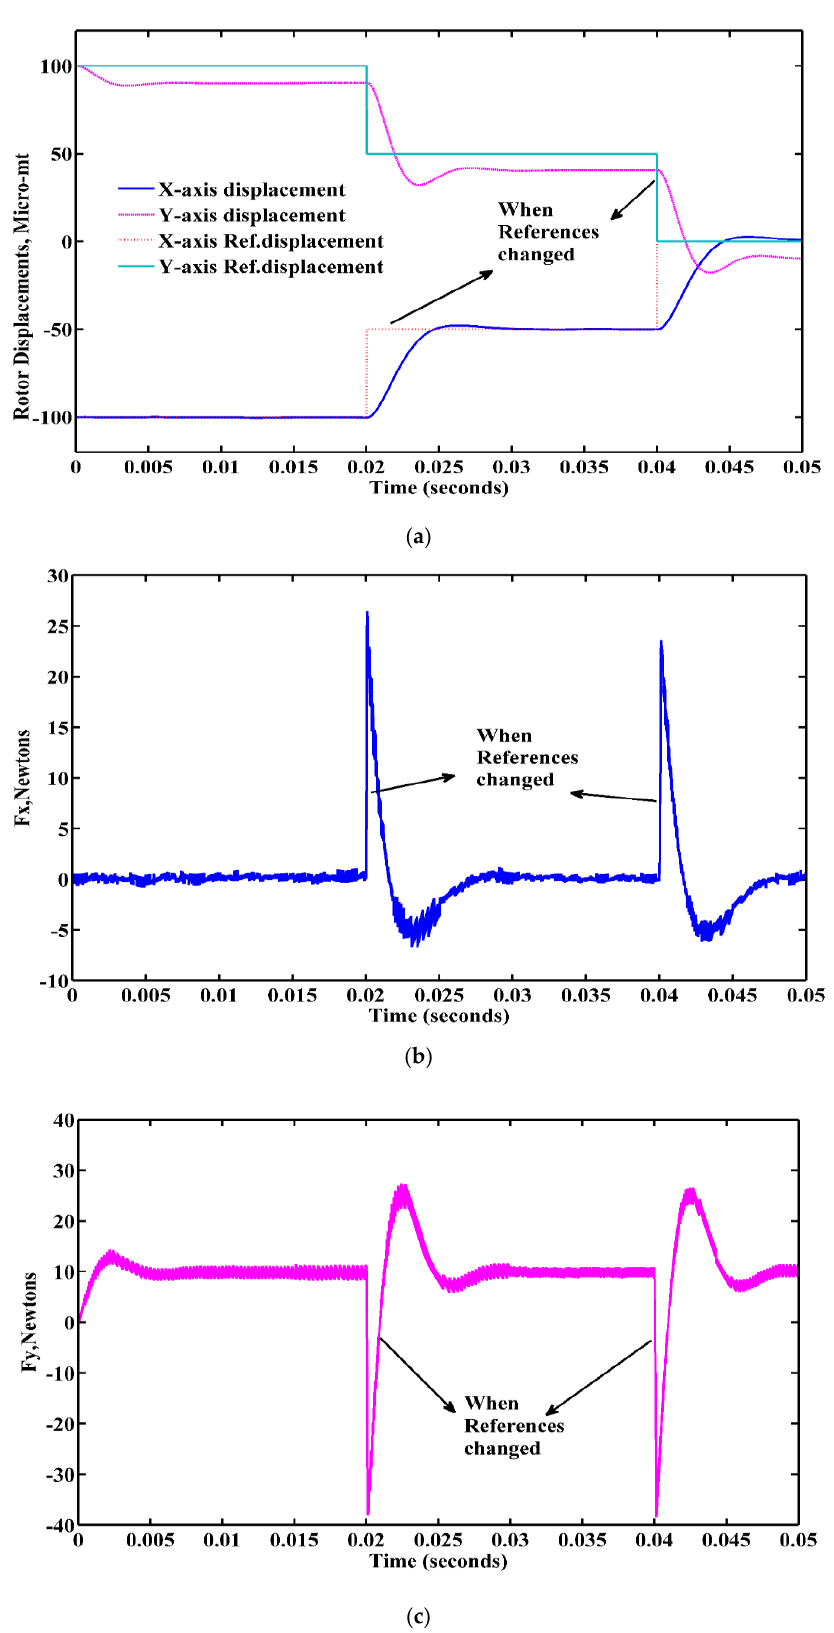
Figure 21. Fourth Quadrant suspension parameters. ( a ) Rotor Xand Y-axis dispalcements when references are changed; ( b ) Suspension force in the X direction; ( c ) Suspension force in the Y direction.